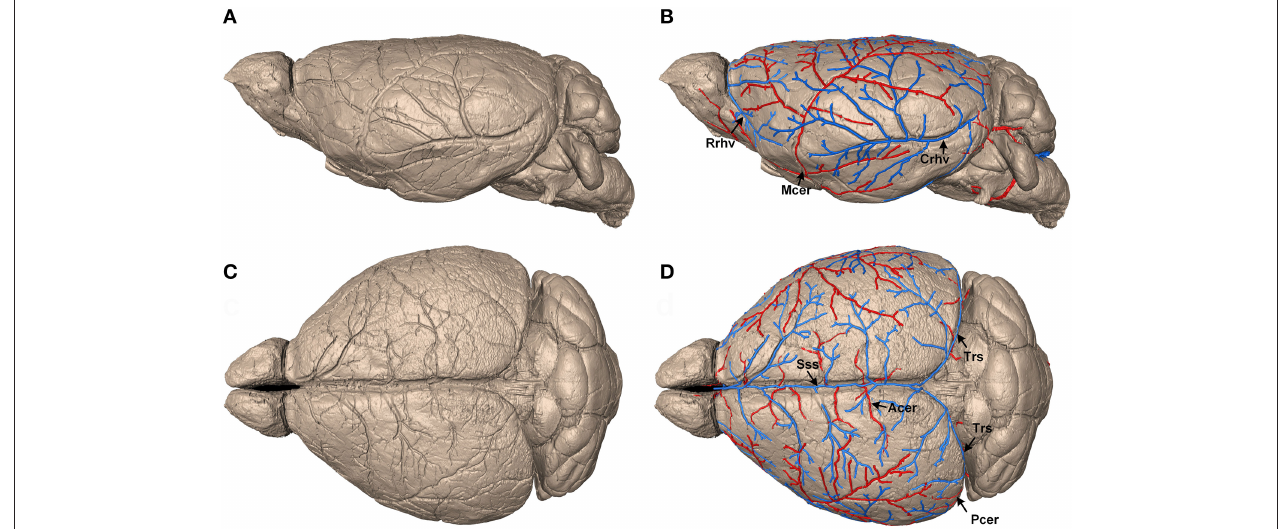
FIGURE 1 | Identification and reconstruction of pial surface vessels. (A,C) Reconstructed 3D mouse brain surface with surface rendering on sagittal and horizontal views, respectively (data resolution is 5 5 5 µ m 3 ). (B,D) Tracing results of the pial surface arteries and veins. Arteries, including Mcer, Acer, and Pcer, are × × presented in red, whereas veins, including Sss, Rrhv, Crhv, and Trs, are in blue. Mcer, Middle cerebral artery; Acer, Anterior cerebral artery; Pcer, Posterior cerebral artery; Sss, Superior sagittal sinus; Rrhv, Rostral rhinal vein; Crhv, Caudal rhinal vein; Trs, Transverse